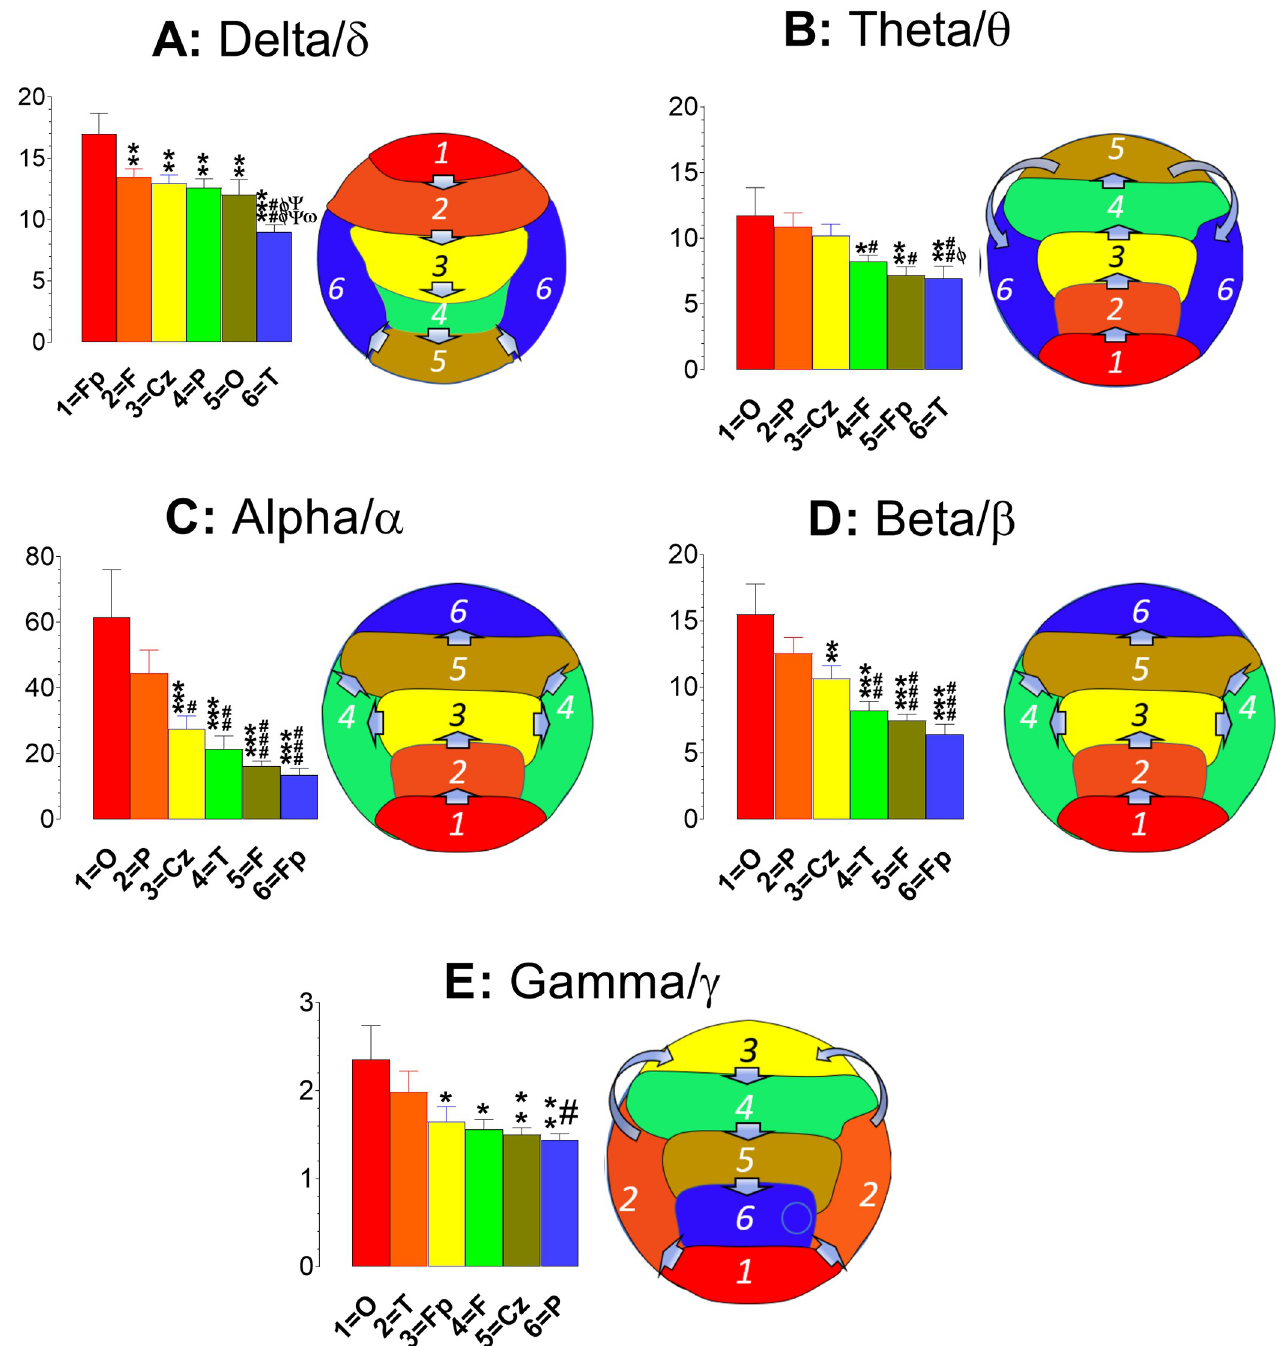
Fig 2. Topographic analysis of the EEG bands at cortical subregions of the healthy brains (N = 20). The y-axis indicates spectral powers ( μ V 2 ) plotted against 6 cortical subregions displaying in x-axis. Data are expressed as the rank orders from the highest to lowest powers in the subregions. Except for delta/ δ waves ( A ), the highest amplitude powers were found in the occipital subregion with characteristic rank orders. Specifically, the theta/ θ powers ( B ) were found in a rank order of O ! P ! Cz ! F ! Fp ! T). � P < 0.05 and �� P < 0.01 vs . 1 = O; # P < 0.05 and ## P < 0.01 vs . 2 = P; ϕ P < 0.05 vs. 3 = Cz. The rank orders for alpha/ α ( C ) and beta/ β ( D ) were identical, displaying O ! P ! Cz ! T ! F ! Fp. �� P < 0.01 and ��� P < 0.001 vs . 1 = O; # P < 0.05, ## P < 0.01 and ### P < 0.001 vs . 2 = P. Interestingly, the gamma/ γ powers were the highest at the occipital subregion and made a turn to the temporal lobe and then the prefrontal subregion, and finally ended at the lowest power in the parietal subregion. �� P < 0.01 vs. 1 = O; # P < 0.05 vs. 2 = T. In contrast, the highest amplitude powers for delta/ δ waves were in the frontal subregions followed by rear subregions, and then the temporal lobes (Fp ! F ! Cz ! P ! O ! T). �� P < 0.01 and ��� P < 0.001 vs . 1 = O; ## P < 0.01 vs . 2 = F; ϕϕ P < 0.01 vs . 3 = Cz; CC P < vs . 4 = P; ω P < 0.05 vs . 5 = O.